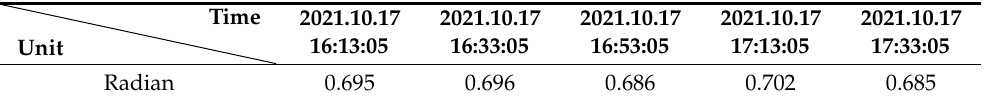
Table 3. After normalization of atmospheric phase